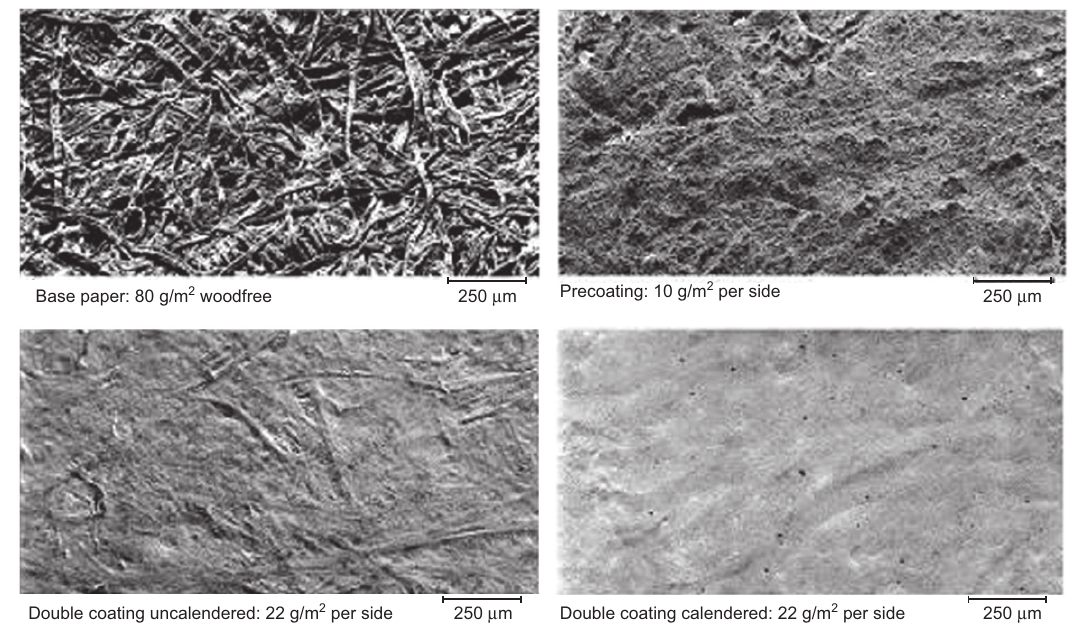
Figure 1 Surface images of uncoated and differently coated papers [17]